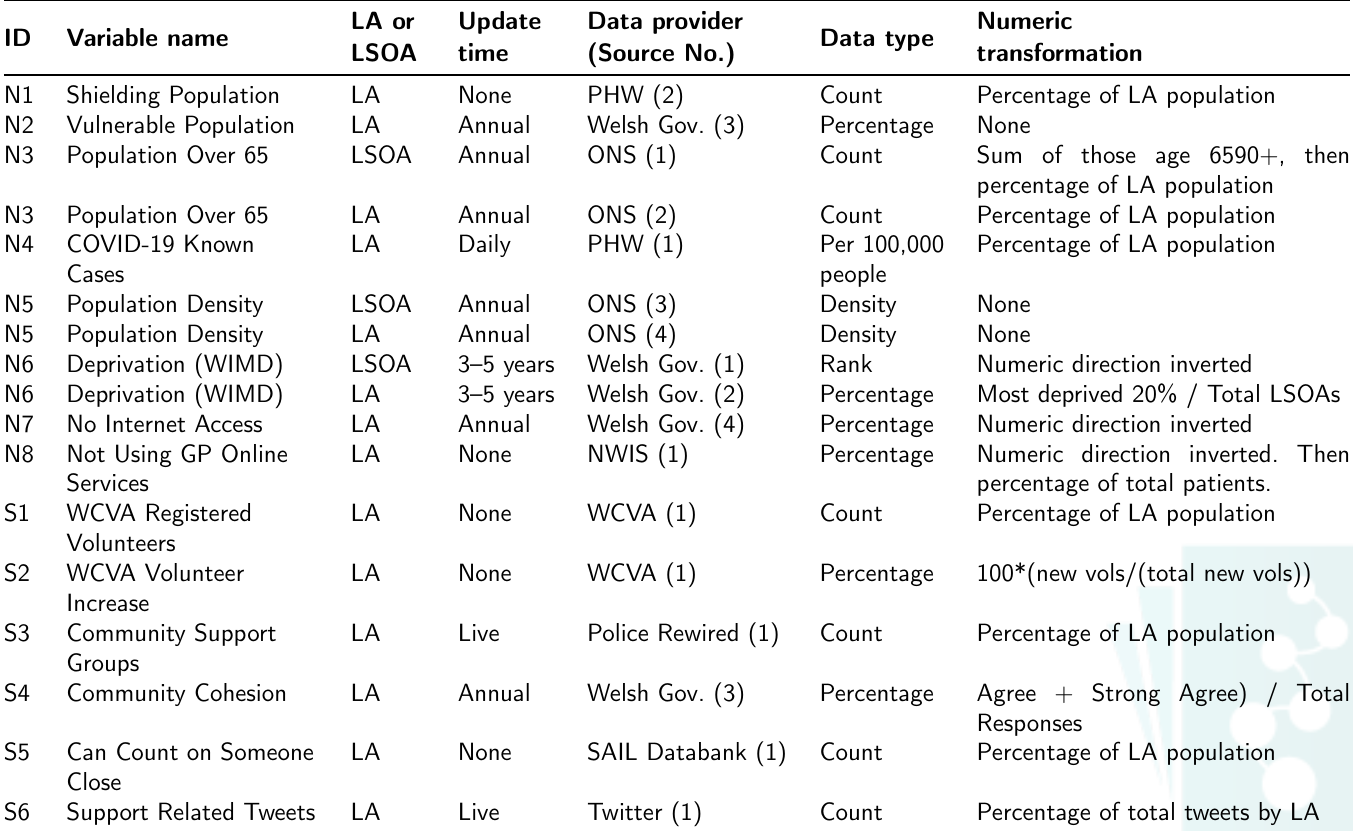
Supplementary Table 1: Further detail about each